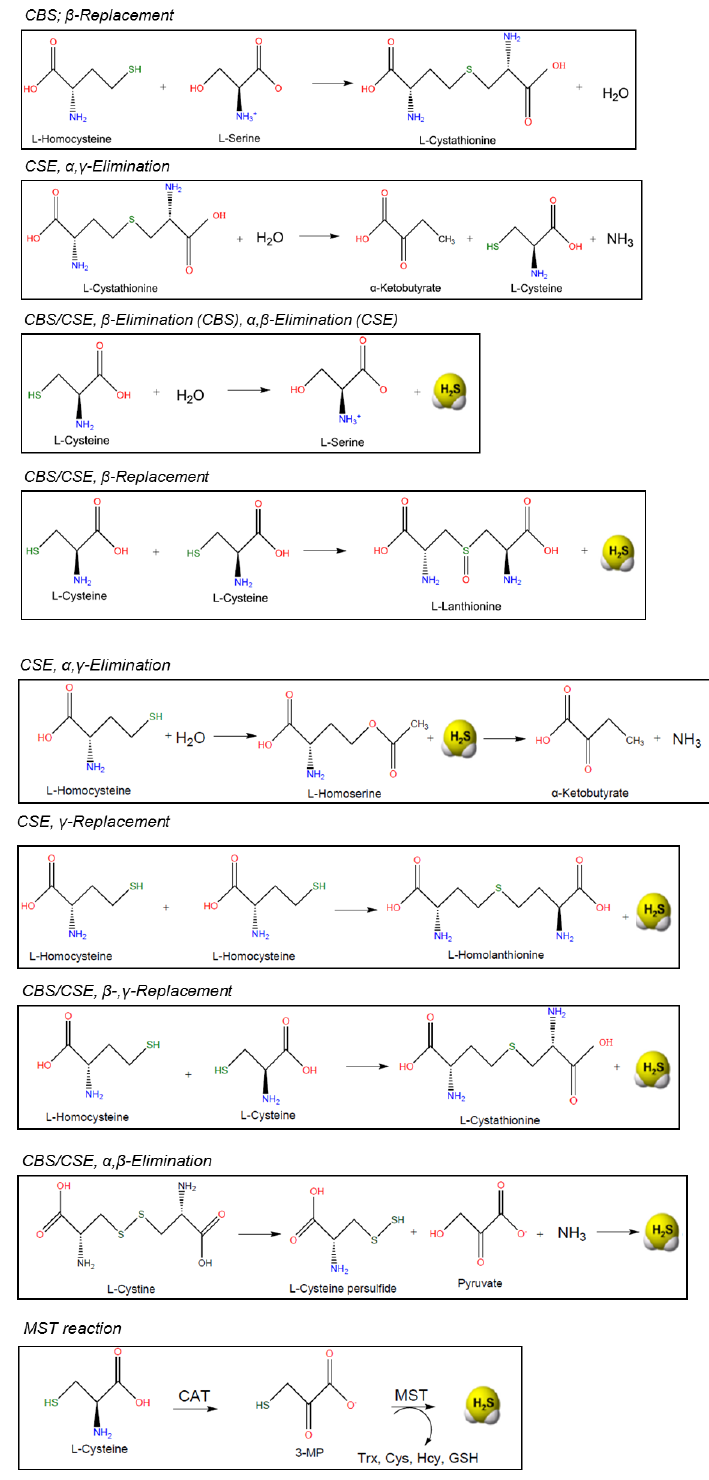
Figure 4. Canonical reactions of cystathionine-β-synthase (CBS), cystathionine-γ-lyase (CSE) and 3-mercaptopyruvate sulfurtransferase (MST). Modified from Giuffre and Vicente [10].